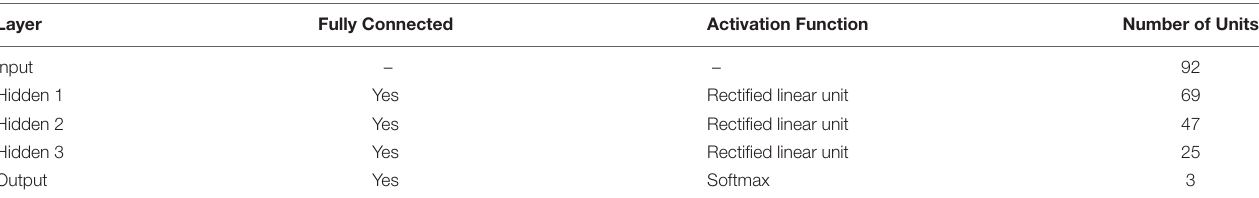
TABLE 1 | Architecture of the multilayer perceptron network for spectral unmixing. Layer Fully